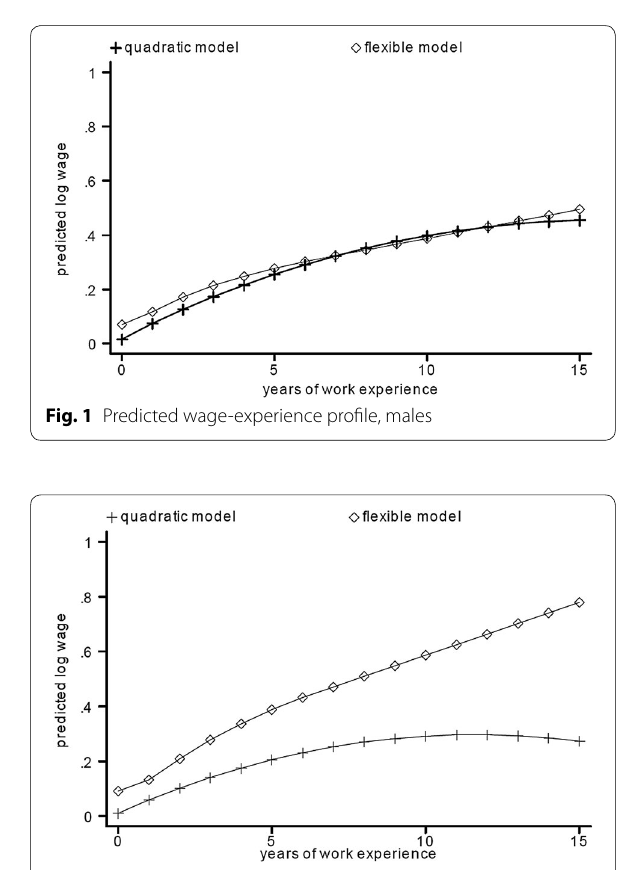
Fig. 2 Predicted wage-experience profile,